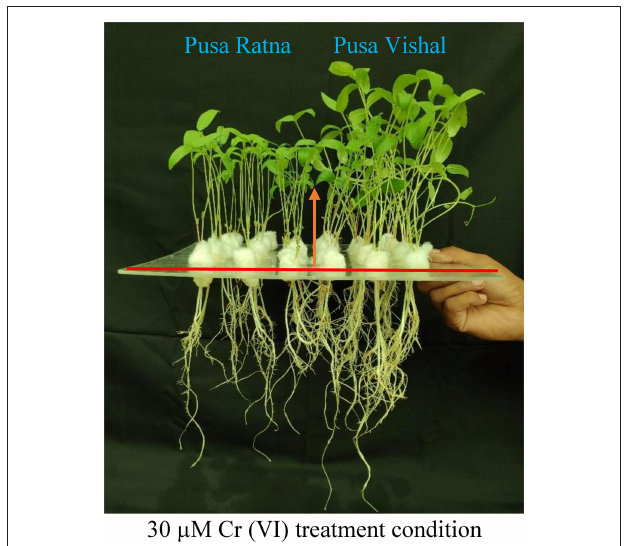
FIGURE 4 | Effect of low chromium (Cr [VI]) treatment level (30 µ M) on the growth of two Mungbean cultivar, Pusa Vishal (PV) and Pusa Ratna (PR) seedlings grown under hydroponic